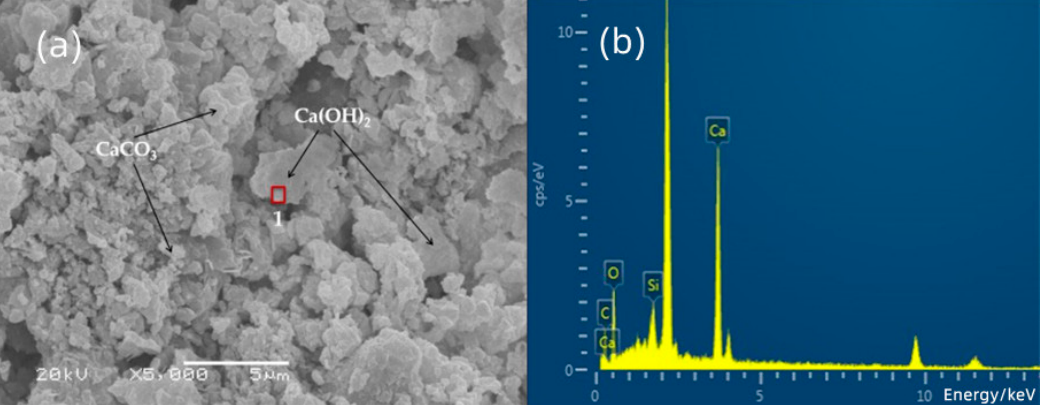
Figure 7. The micromorphology and EDS results of the hydraulic lime K3 fractured samples at 3 days: ( a ) SEM image of K3 mortar curing 3 days; ( b ) EDS result.